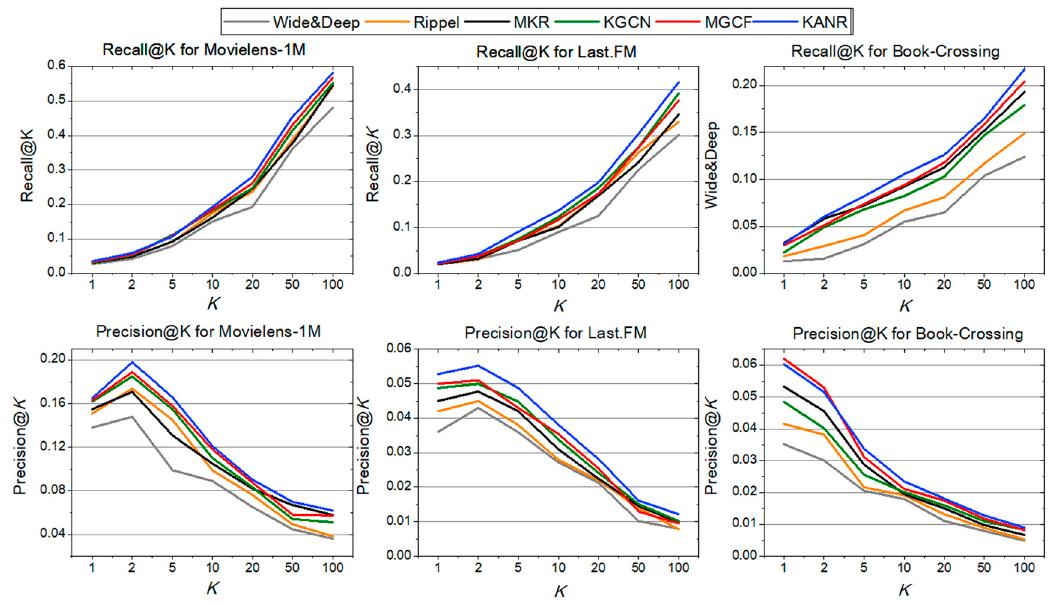
Figure 4. Performance display of each model in the Top ‐ K experiment.